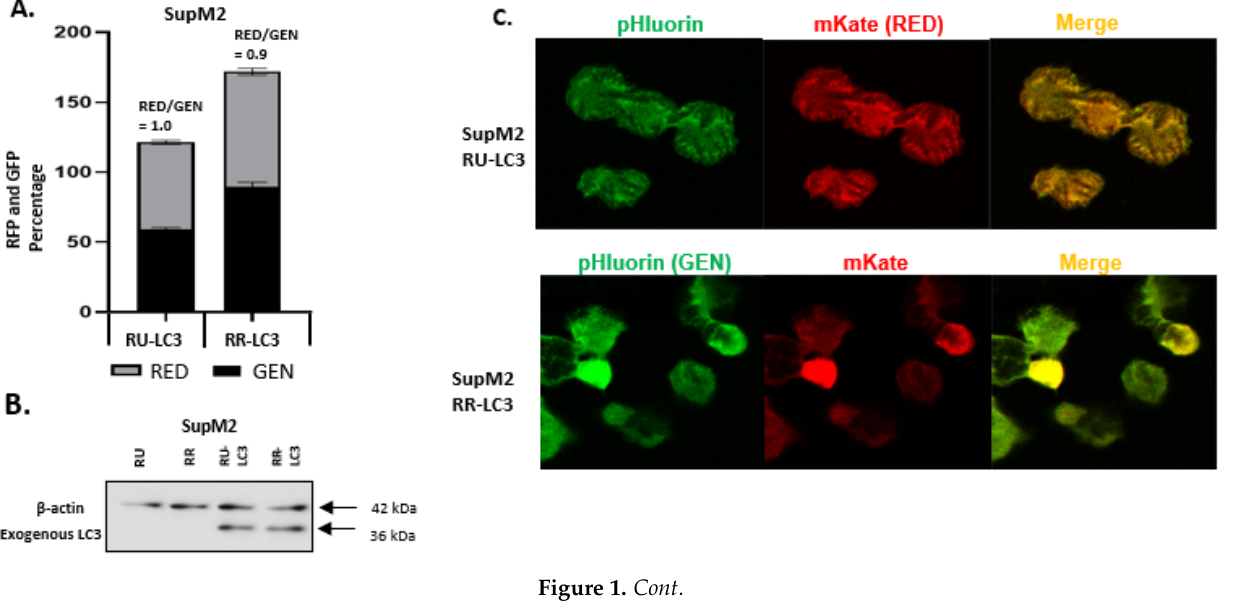
Figure 1. Crizotinib-induced autophagy activity is significantly enhanced in Reporter Responsive (RR) cells than Reporter Unresponsive (RU) cells. ( A ) RED/GEN ratio in LC3 transduced SupM2 RU and RR subset cells. SupM2 RU cells were used as the baseline of GEN and RED. ( B ) Western blotting analysis to confirm the transduction of exogenous LC3 in SupM2 RU and RR cells. The bands at 36 kDa were exogenous LC3 fused with fluorescent probes. ( C ) Confocal microscopy was performed to verify the expression of exogenous LC3. RU-LC3 and RR-LC3 at the steady state showed the co-expres- sion of both red and green fluorescence signals; cells were visualized with phase contrast. ( D ) ( a ) RED/GEN ratio in SupM2 RU-LC3 and RR-LC3 cells following treatment with 0, 125, 250, and 500 nM of crizotinib. Cells were collected for flow cytometry measurement after 24 h. ( b ) Data provided in A is expressed as percentages of change for each crizotinib dosage. Data normalized to control dimethyl sulfoxide (DMSO/Crizotinib at 0 nM) group, respectively. ( E ) Changes in LC3 protein level in response to crizotinib are different between RU and RR cells. Western blot analysis of SupM2 RU and RR cells treated with different dosages of crizotinib (0, 125, 250, and 500 nM) with or without 5 µM of chloroquine for 24 h. Original blots are shown in Figure S4. ImageJ Software was used to measure bands intensity. Three independent experiments were